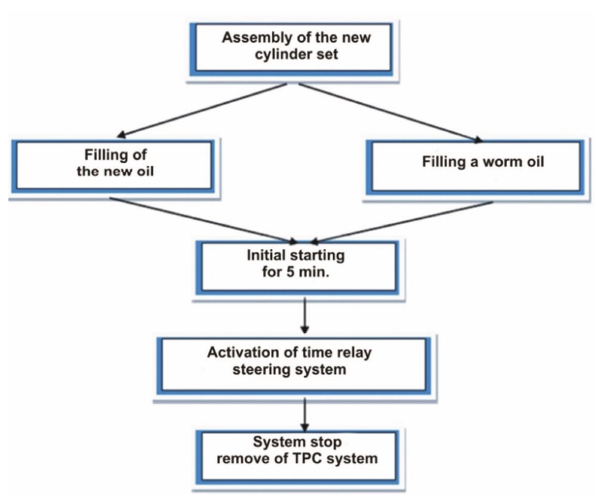
Fig. 6. The scheme of experiment processing